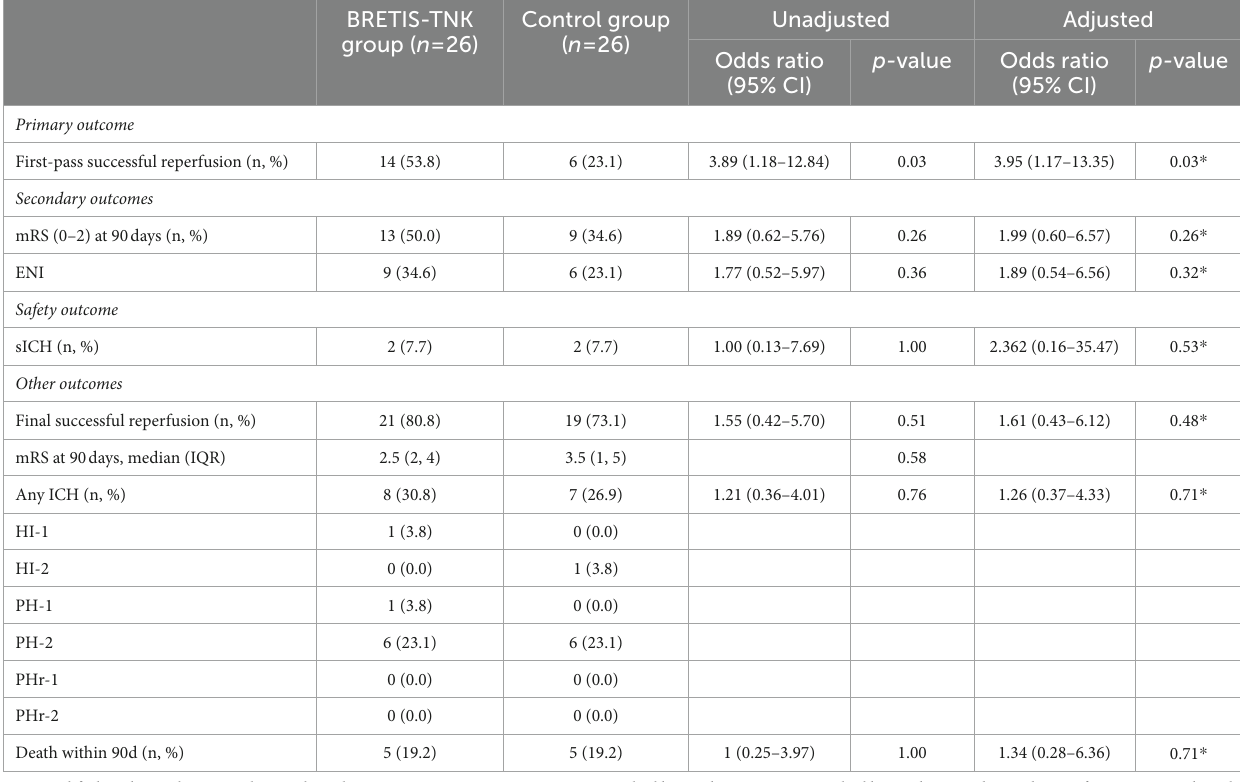
TABLE 3 Outcomes after propensity score